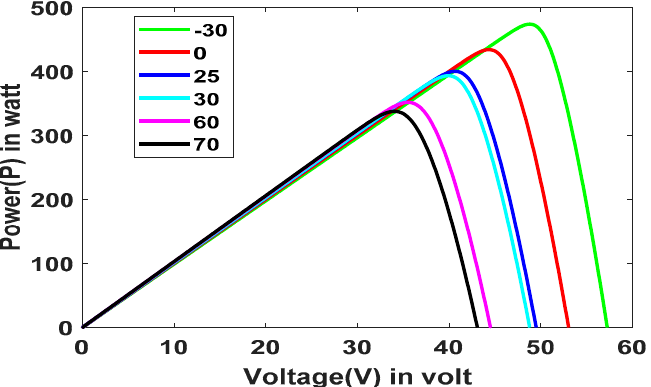
Figure 13. PV curve obtained from simulation for Module AS-M3607-S (G1 CELLS) at various temperatures ranging from − 30 ◦ C to 70 ◦ C at a fixed irradiance of 1000 W/m 2 using the Hybrid BESSA technique.